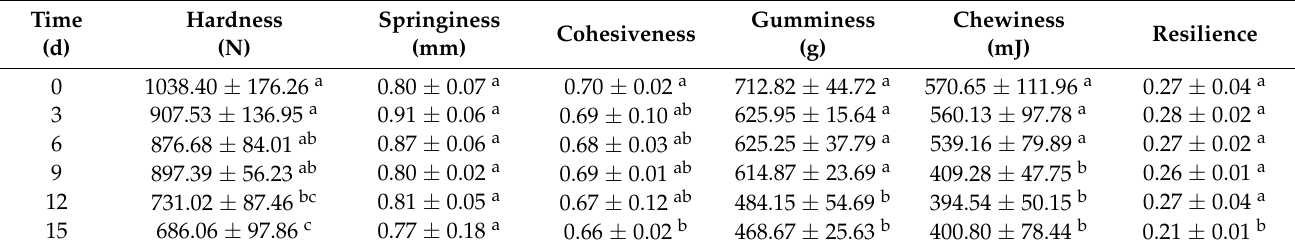
Table 1. Texture profile analysis of egg white with salting time.